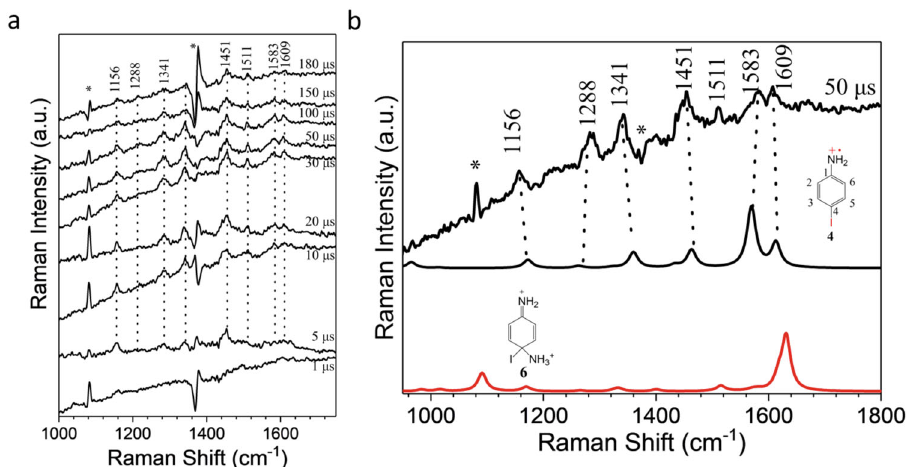
Fig. 5 Nanosecond time-resolved resonance Raman spectroscopy (ns-TR 3 ) spectra of the precursor 1 in pure MeCN by employing a 355 nm probe laser and a 240 nm pump laser. a spectra obtained at different delay times. Asterisks represent solvent substraction artifacts, ( b ) spectrum at 50 µ s (top), computed normal Raman spectra of the radical cation 4 (middle, with the structure shown) and dication 6 (bottom, with the structure shown) using DFT/ M06-2X calcaultion. Asterisks represent solvent substraction artifacts. The Cartesian Coordinates of the computed structures are shown in the Supplementary Data